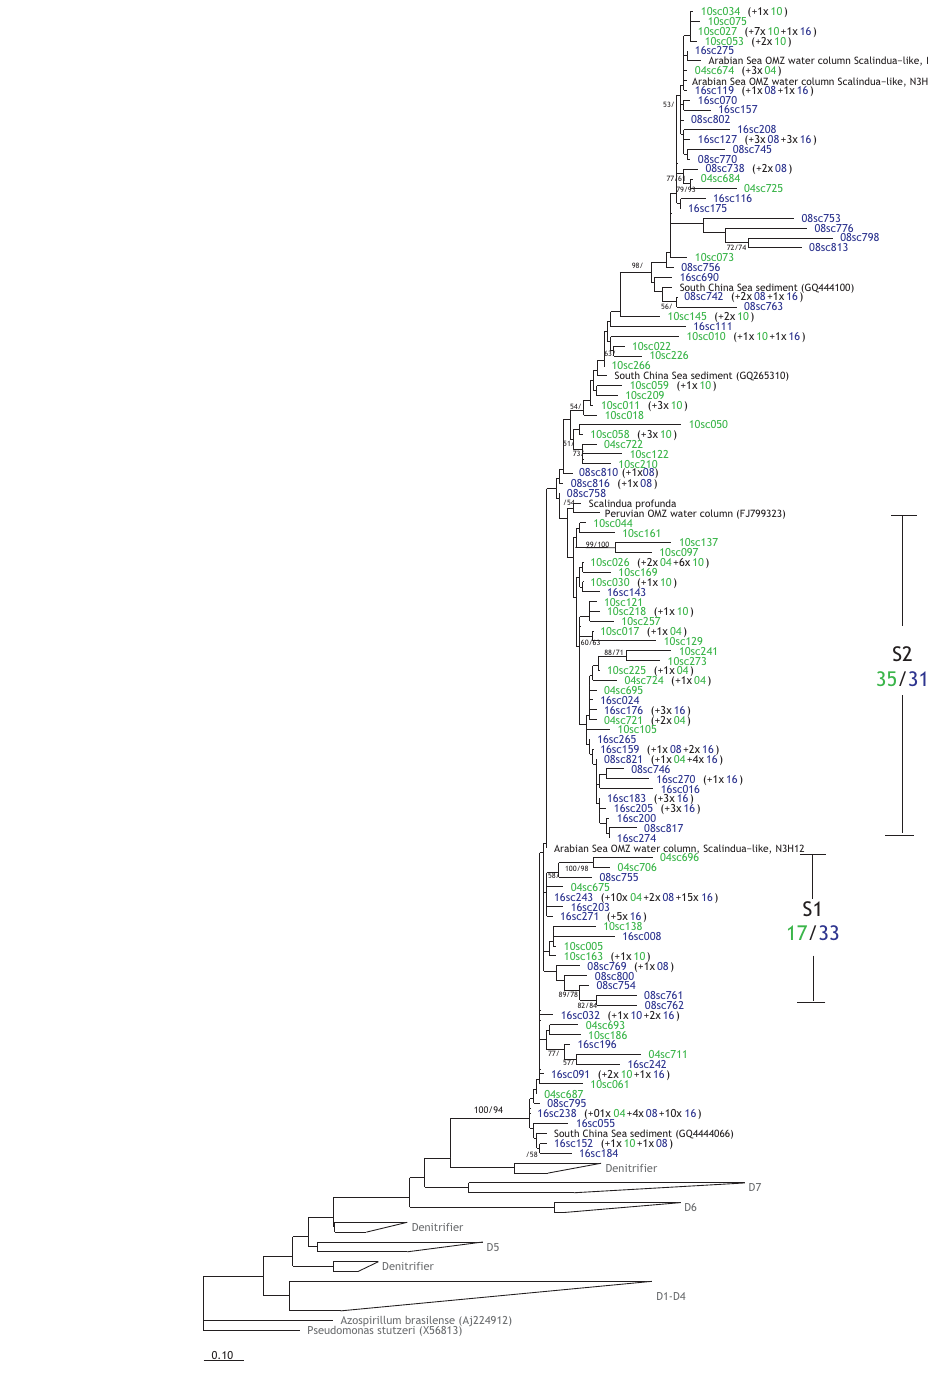
were obtained from the shallow stations (10 and 04). Please refer to Figure 6 for additional information regarding the sequence labels in